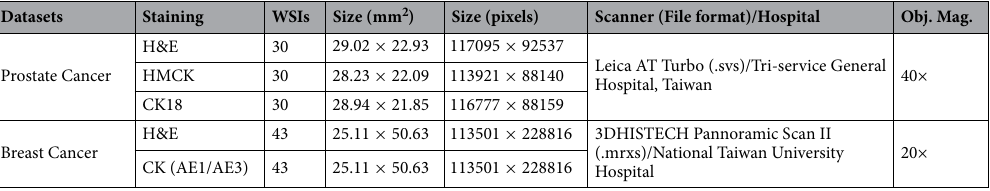
Table 1. Information of the experimental